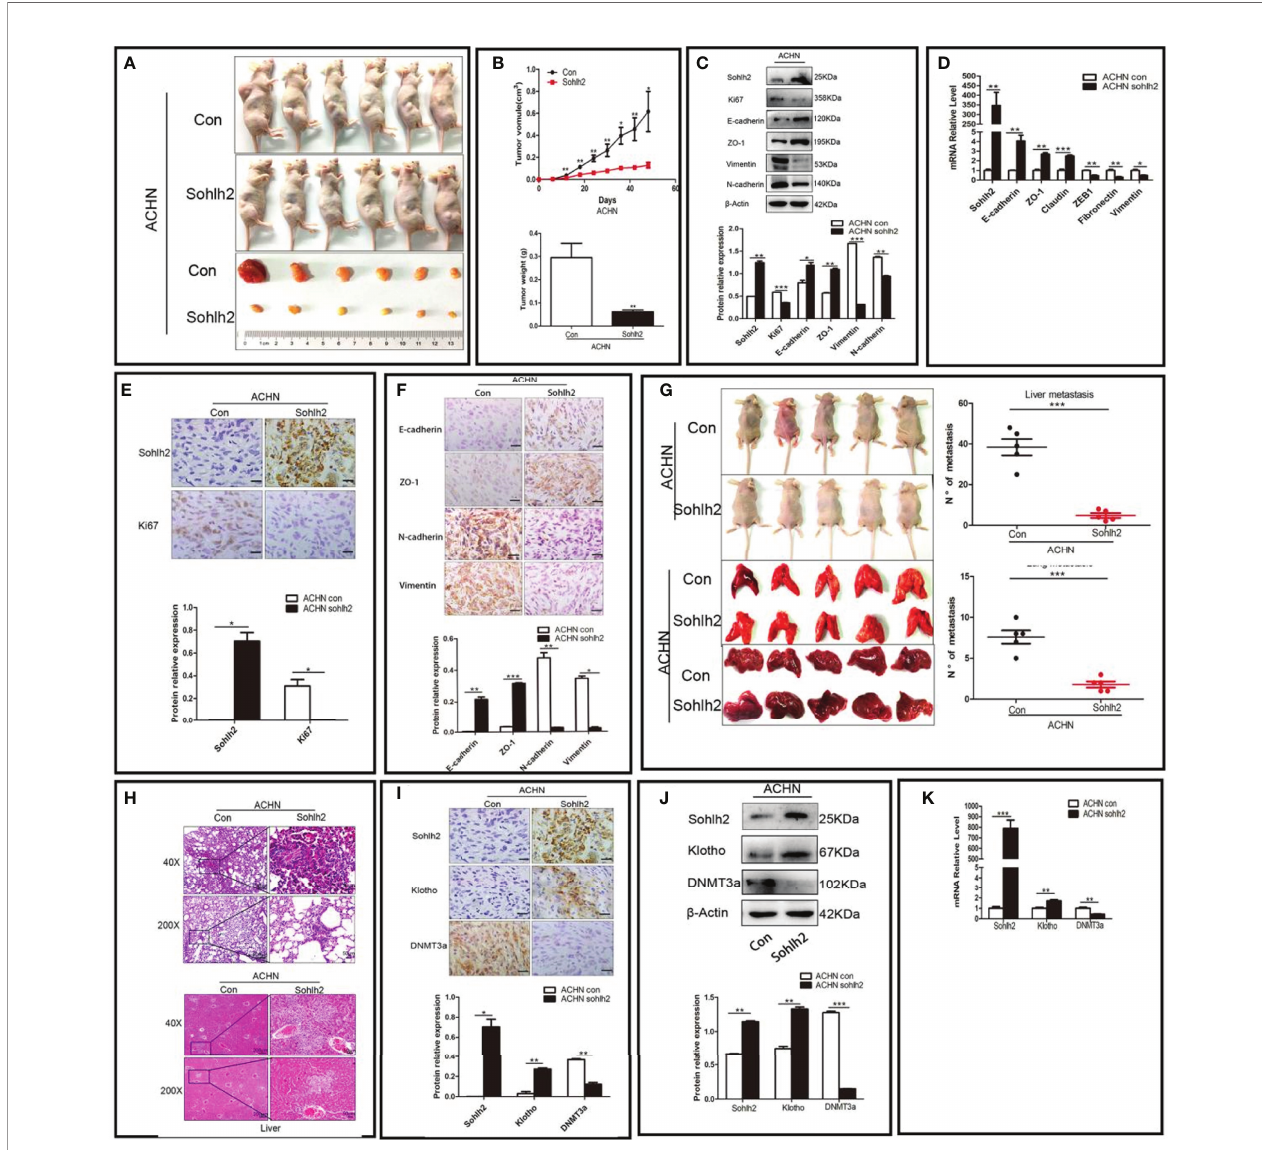
FIGURE 4 | Sohlh2 inhibited RCC growth and metastasis in vivo . (A) Pictures of mice and tumors from the control and Sohlh2 overexpression ACHN groups. n = 6. (B) The quantitative analysis of tumor volume (above) and weight (below) in the control and Sohlh2 overexpression ACHN xenografts. (C) The Western blotting results of the effects of Sohlh2 on RCC EMT and proliferation. (D) The qPCR results of the effects of Sohlh2 on RCC EMT. (E, F) The representative immunohistochemical staining results of the effects of Sohlh2 on RCC proliferation and EMT. (G) The pictures of mice, lungs, and livers from the control and Sohlh2 overexpression ACHN groups (left) and statistical analysis of metastases in the lung and liver (right). n = 5. (H) The H&E staining results of tumor metastases in the lungs (above) and livers (below). (I) The immunohistochemical staining results of the effects of Sohlh2 on Klotho and DNMT3a expression levels. (J, K) The Western blotting and qPCR results of the effects of Sohlh2 on Klotho and DNMT3a expression levels. RCC, renal cell carcinoma; EMT, epithelial – mesenchymal transition. (*P < 0.05; **P < 0.001; ***P <